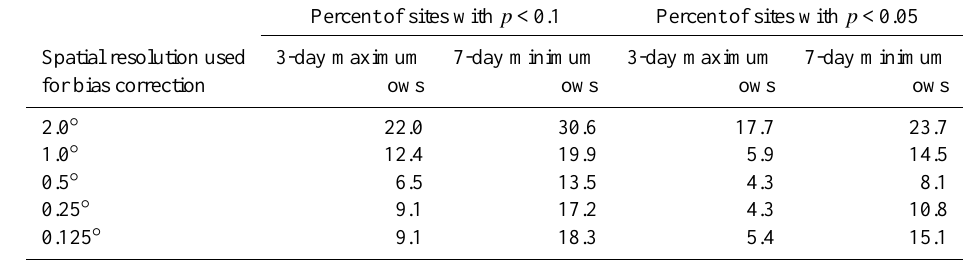
Table 1. Summary of the percentage of streamflow sites with p <0.1 and p <0.05 (shown in Figs. 8 and 9). Percent of sites with p <0.1